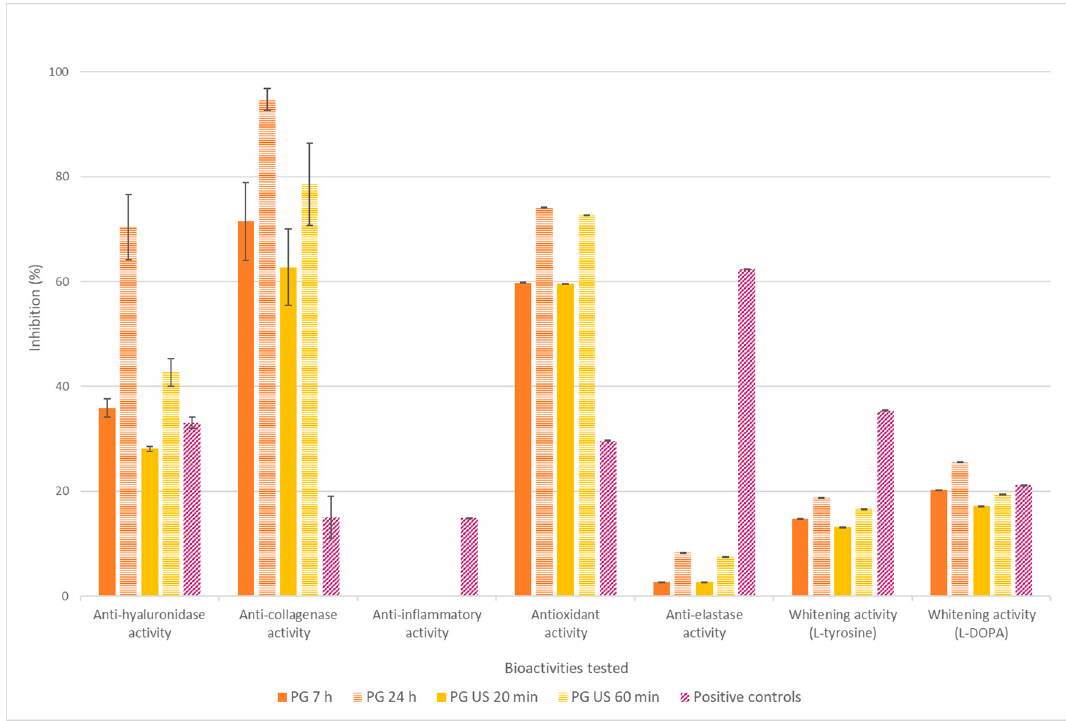
Figure 6. Bioactivities of R. nigrum pomace extract obtained by ultrasound-assisted maceration for 20 and 60 min, compared to the bioactivities of extracts obtained by conventional 7 h- and 24 h- macerations.